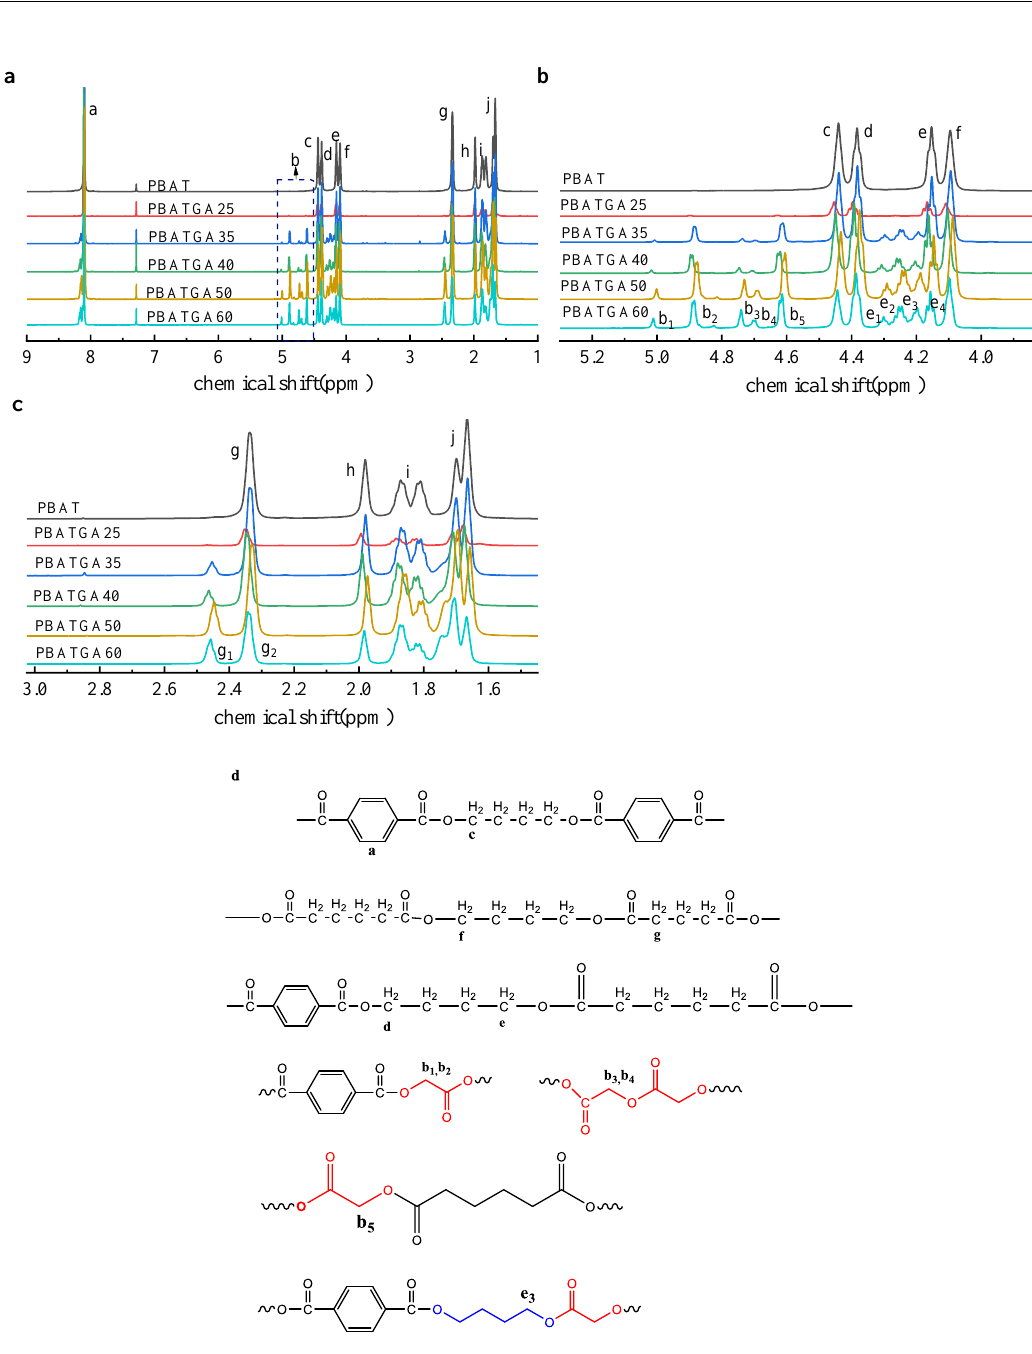
Figure 2. ( a ) 1 H NMR spectra of PBATGAs; ( b ) enlargement of chemical shift 4.0 – 5.2 ppm; ( c ) enlargement of chemical shift 1.6–3.0 ppm; and ( d ) chain structures of the